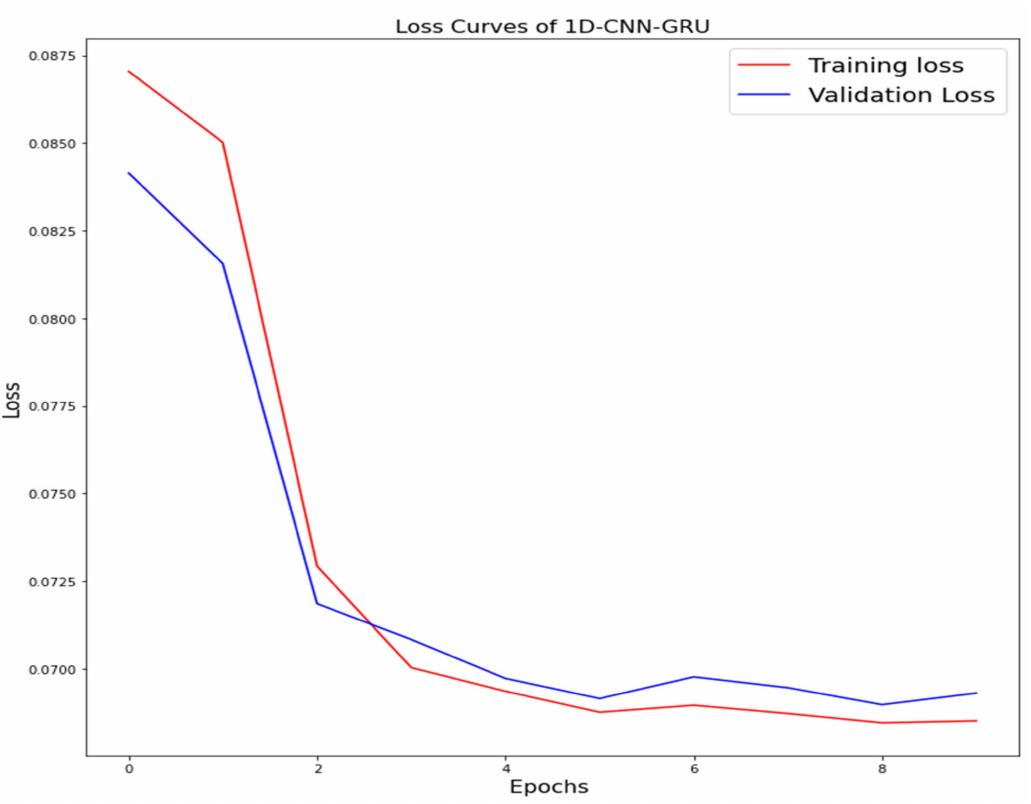
Figure 10. Loss curve of one-dimensional convolutional gated recurrent unit neural network (1D- CNN-GRU).